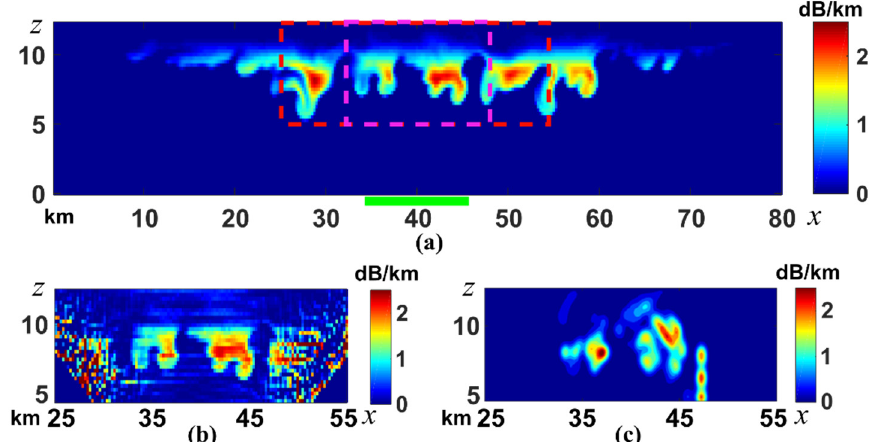
Figure 8. Simulation results for partial retrieval. Panel ( a ) shows the reference field and the location of 11 receivers (green bar). Panel ( b ) shows the retrieved field using 120 × 30 rectangular basis functions defined in the area marked by the red dashed line in panel ( a ). Panel ( c ) shows the retrieved field using 30 × 15 Gaussian basis functions defined in the area marked by the purple dashed line in panel ( a